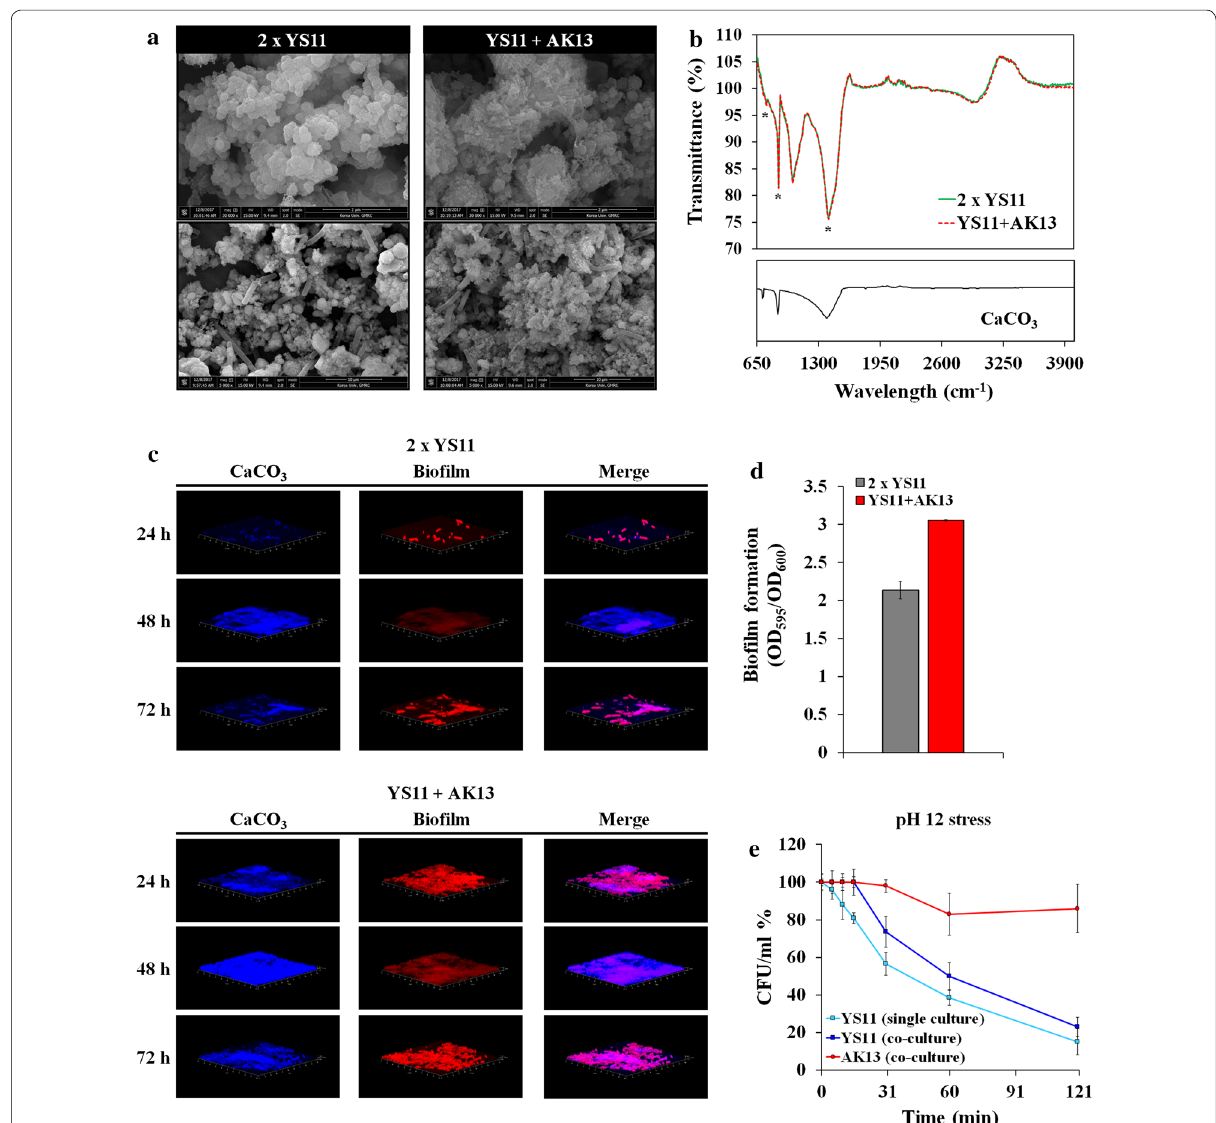
Fig. 4 a Field emission scanning electron microscopy (FE-SEM) of calcium carbonate precipitated by YS11 single culture and YS11 ( 30,000 and 5000 magnification). b FTIR analysis of precipitated calcium carbonate. c CLSM image of biofilm and calcium carbonate produced × × by YS11 single culture. d Crystal violet quantification of biofilm formation in single culture or YS11 alone, AK13 alone, and YS11 plus AK13 under pH